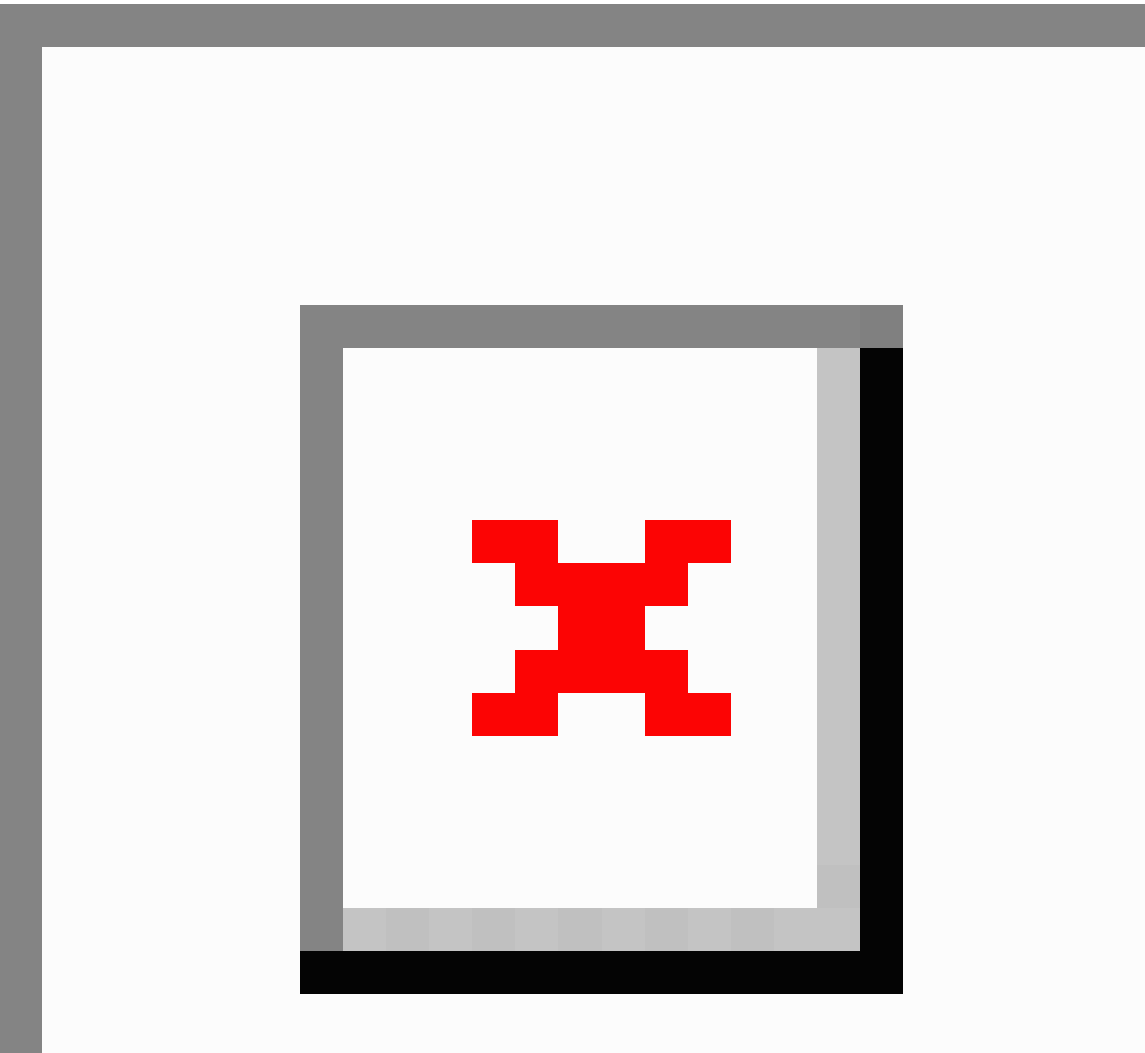
Figure 1. Diagnostic accuracy of digital fundus photography by area under receiver operating curve. Panel A: hand-held camera and Panel B: desk-based